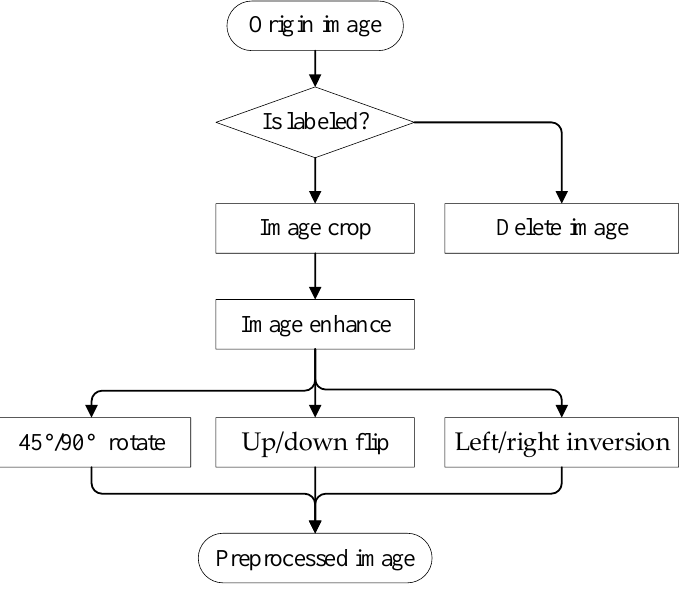
Figure 5. Image preprocessing flow. The image-weighted enhancement can be formulated as Equation (5).